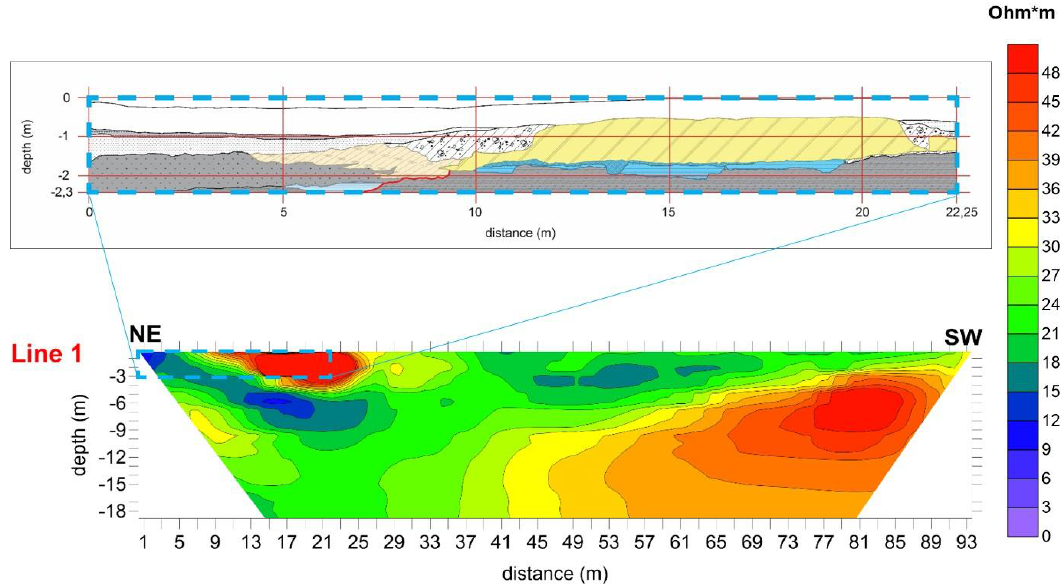
Figure 8. Comparison between mirrored L1 ERT line and stratigraphic section with preserved rampart.